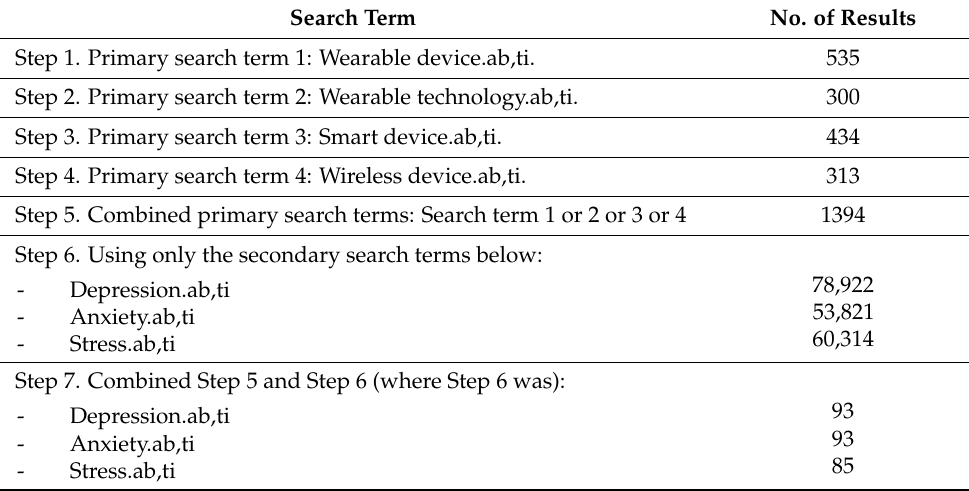
Table 3. The search structure for the Cochrane Central database. Search Term